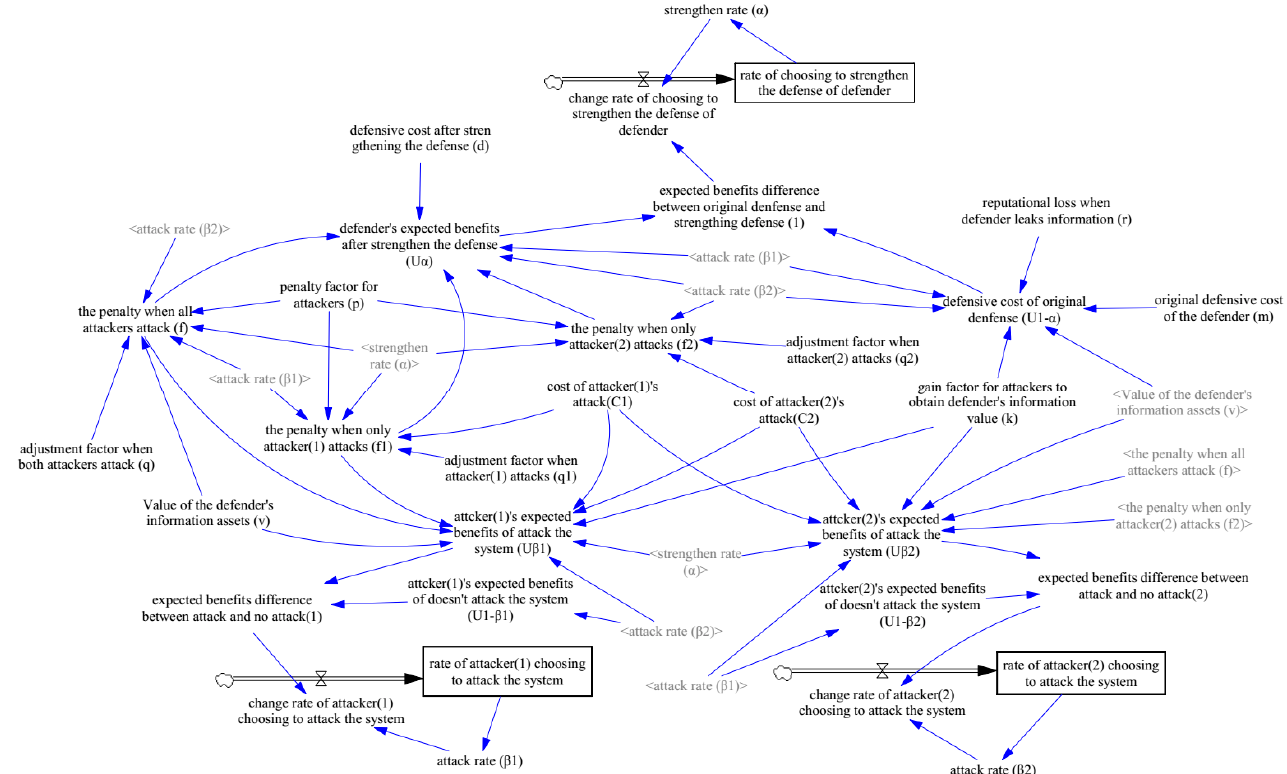
Figure 8. Evolutionary game SD model under the dynamic penalty scheme. Set the initial strategy of defender, attacker (1) and attacker (2) to α = 0.1, β 1 = 0.4, and β 2 = 0.9, and α = 0.5, β 1 = 0.5, β 2 = 0.5; the simulation results are shown in Figures 9 and 10.